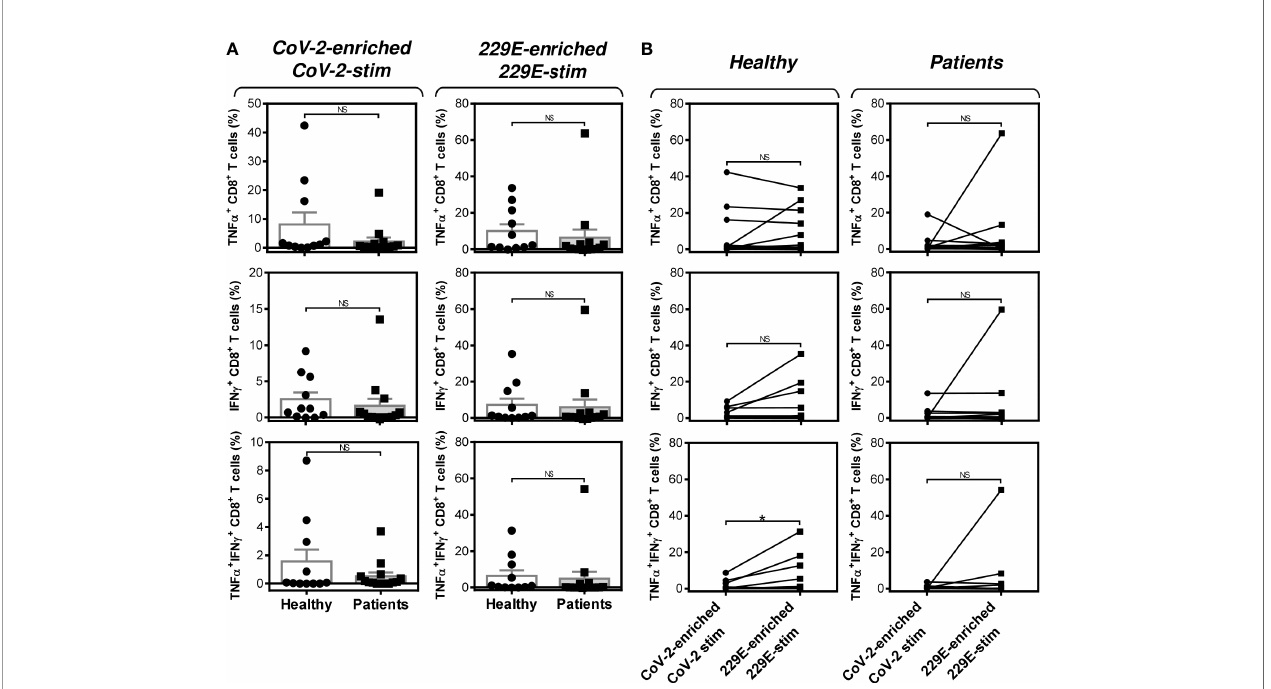
FIGURE 5 | Impact of PCa on the peptide pool-mediated cell culture enrichment with the peptide-speci fi c TNF a -, IFN g -, or TNF a /IFN g -producing CD8 + T cells (A) Cell cultures of 11 healthy male volunteers (Healthy) and 14 HR metastatic PCa patients (Patients) were enriched with the SARS-CoV-2 (CoV-2) (left) or HCoV-229E (229E) (right) peptide pool and stimulated with the corresponding peptide pool and proportions of TNF a -, IFN g -, or TNF a /IFN g -producing CD8 + T cells was determined. (B) The differences in responsiveness of CD8 + T cells to SARS-CoV-2 (CoV-2-enriched/CoV-2-stim) and HCoV-229E (229E-enriched/229E-stim) peptide pools in A was evaluated between the group of healthy male volunteers (Healthy) and HR metastatic PCa patients (Patients). In A , bars represent mean of values and SEM determined in each group and signi fi cances of differences between the groups are indicated ( n = 11 healthy male donors (Healthy) and n = 14 HR metastatic PCa patients (Patients), Mann-Whitney U test). In (B) , signi fi cances of differences between the groups are indicated (* P <0.05, n = 11 healthy male donors (Healthy), n = 14 HR metastatic PCa patients (Patients), Wilcoxon matched-pairs signed-ranks test). In (A, B) , P >0.05 were considered nonsigni fi cant